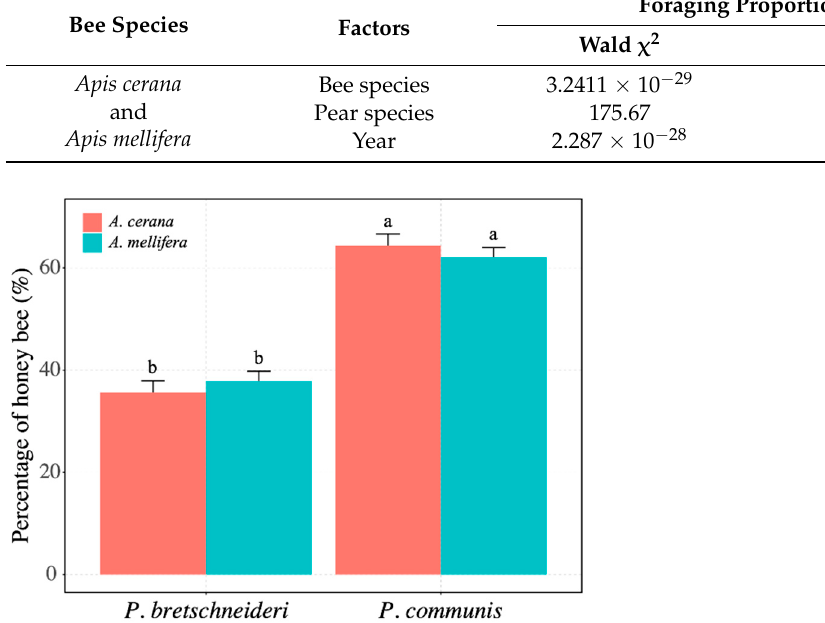
Figure 3. The mean proportions of A. cerana and A. mellifera foraging on P. communis and P. bretschneideri (mean ± SE; n = 13 for both bee species). Different letters indicate a significant difference ( p < 0.05).